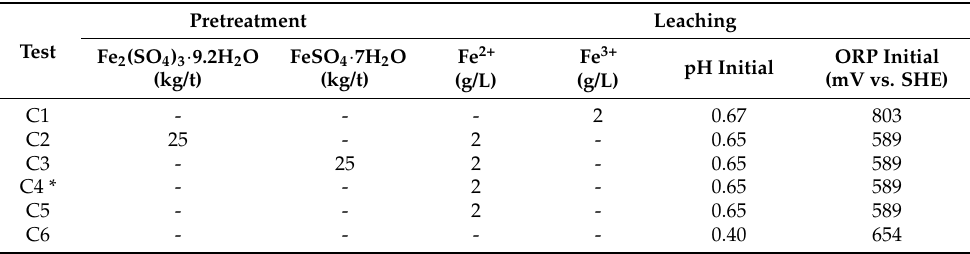
Table 5. Experimental conditions of pretreatment (25 kg/t H 2 SO 4 , 50 kg/t NaCl, humidity 6%, 30 d of curing time) and leaching (0.5 g/L Cu 2+ , 80 g/L Cl − , 10 g/L H 2 SO 4 ), tests